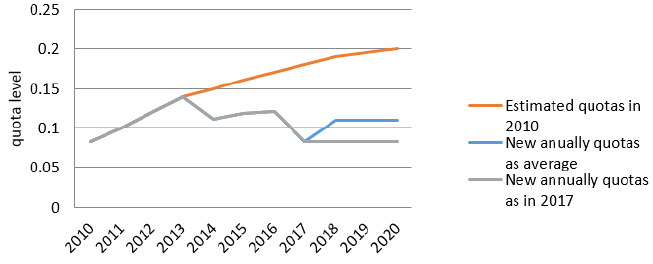
Figure 4. Different quotas as a consequence of legislation modification.